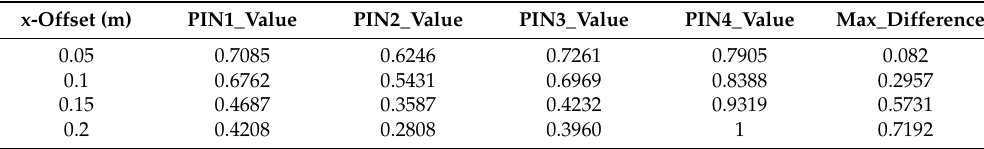
Table 1. Estimated ADC value difference at different x-offsets when the radius of the PIN circle is 0.2 m and the distance is 1.1 m.